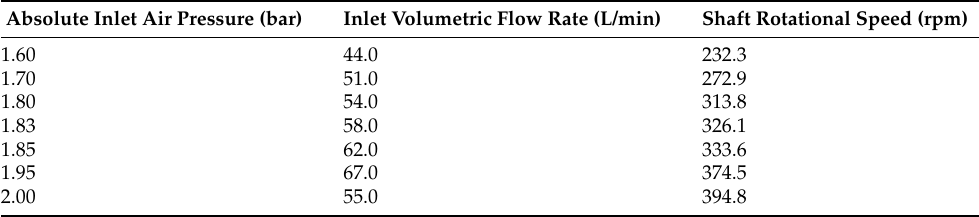
Figure 10. Experimental setup and schematic diagram of the expander motor. Table 3. Experimental test apparatus outcomes.